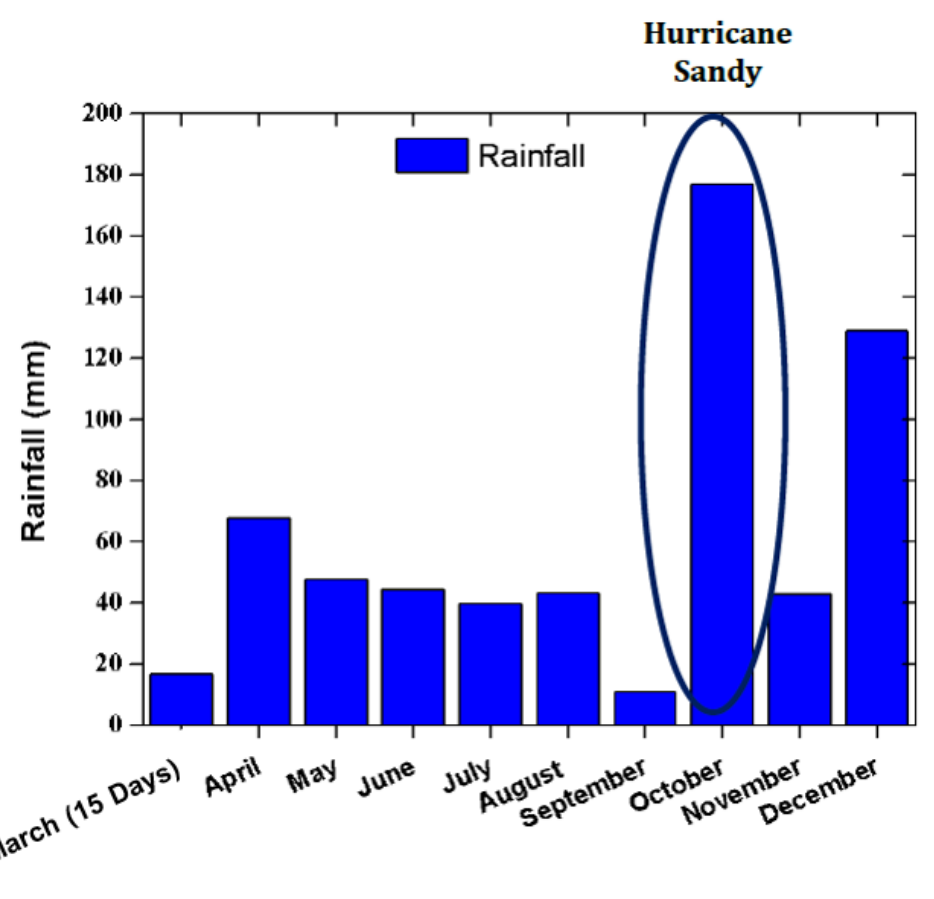
Figure 8. Total rainfall data in the farm.